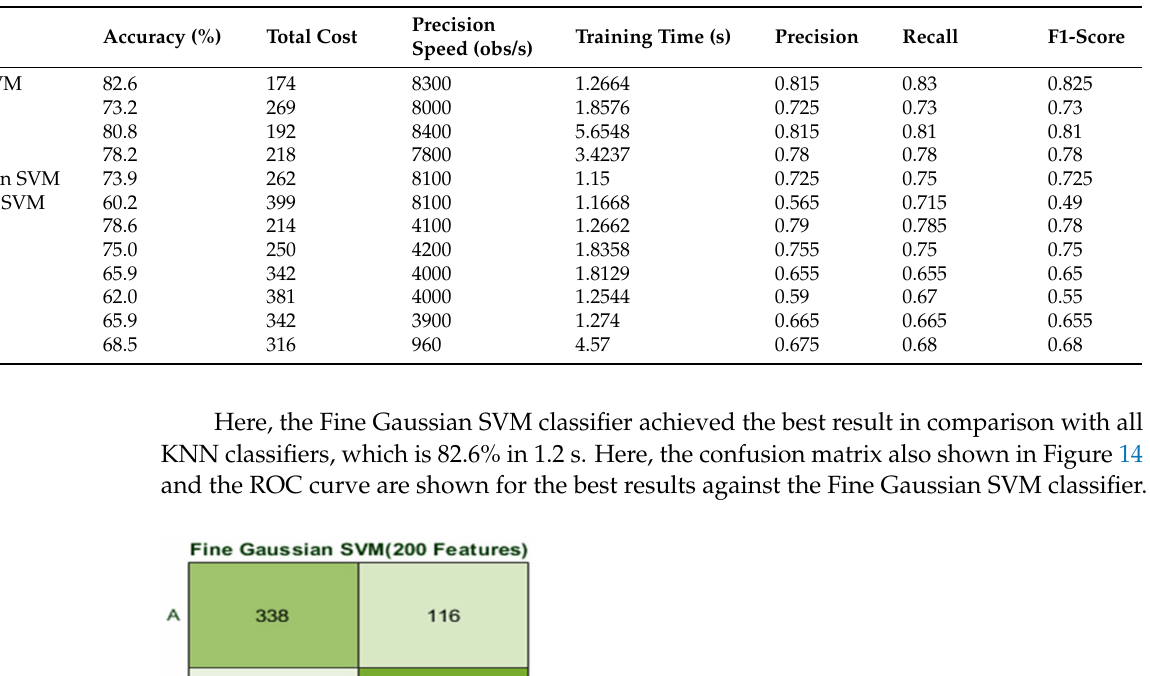
Table 7. Experiment_2 using 10 Folds (200 Feature).